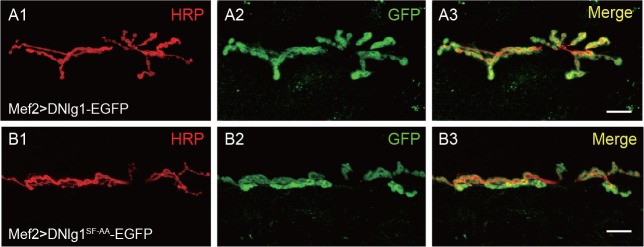
DNlg1SF-AA, the mutant form of DNlg1, can be normally targeted to postsynaptic sites.Confocal images of (A) Mef2 >DNlg1 EGFP (Mef2-Gal4/+; UAS-DNlg1-EGFP/+) and (B) Mef2 >DNlg1 SF-AA-EGFP (Mef2-Gal4/+; UAS-DNlg1SF-AA-EGFP/+) third instar larvae NMJ type Ib boutons labeled with anti-HRP (red). Note that the green fluorescence signal indicates the expression of the EGFP protein. Both DNlg1-EGFP and DNlg1SF-AA-EGFP could be targeted to postsynaptic sites when they were driven by muscle-specific Gal4 Mef2-Gal4. Scale bars: (A, B) 20 μm.